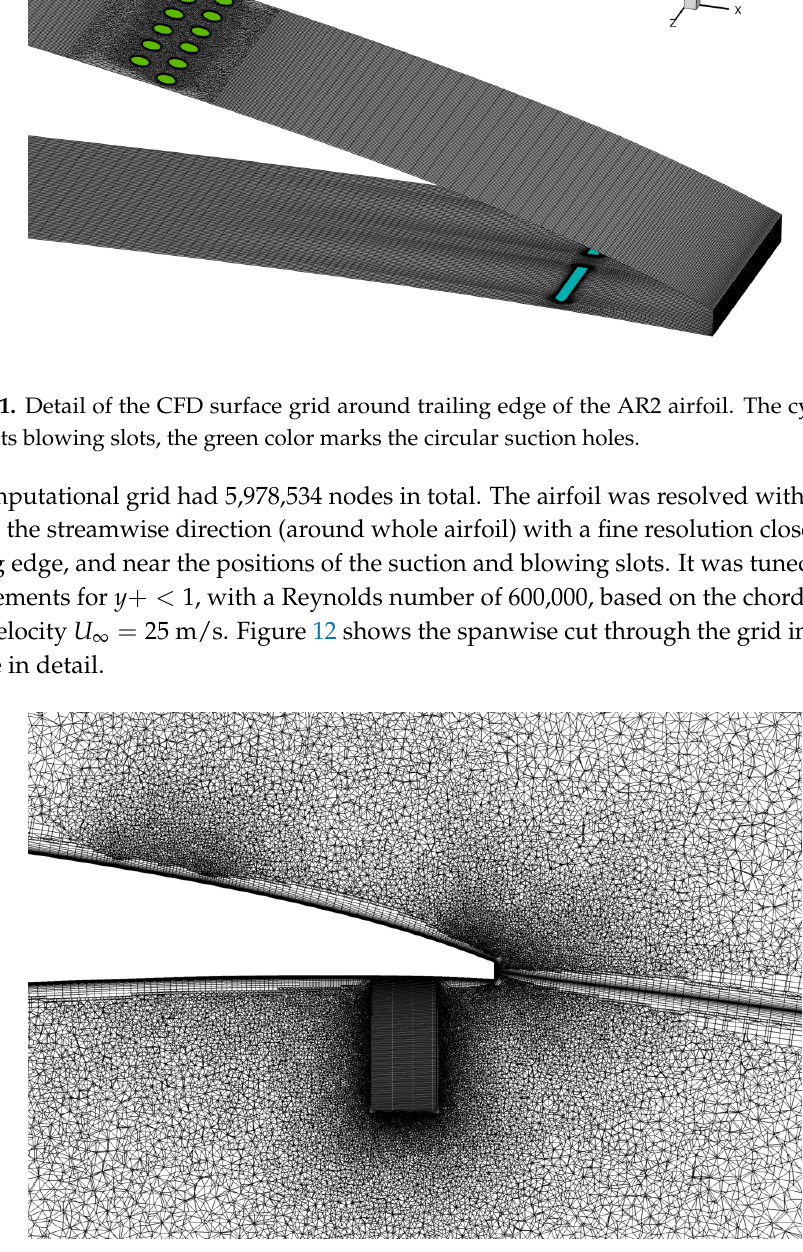
Figure 12. Detail of the spanwise cut through the CFD grid close to the trailing edge of the AR2 airfoil. A structured block, to resolve oscillatory blowing and the wake, is